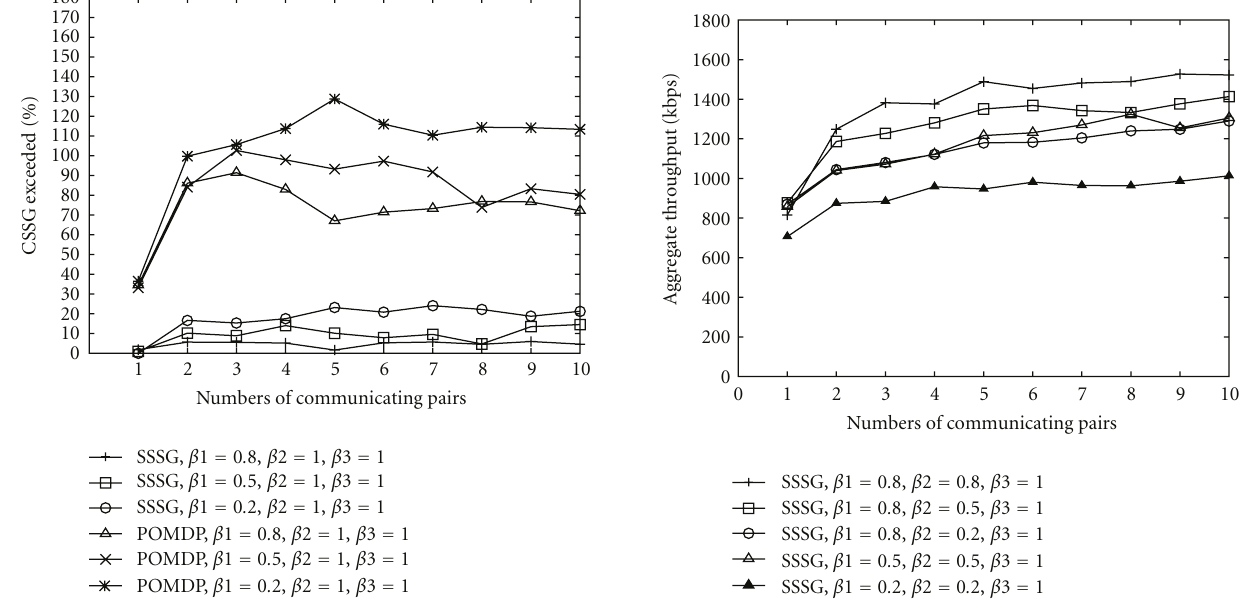
Figure 15: Various cases compare with CSSG with 1 channel having PU’s interference.